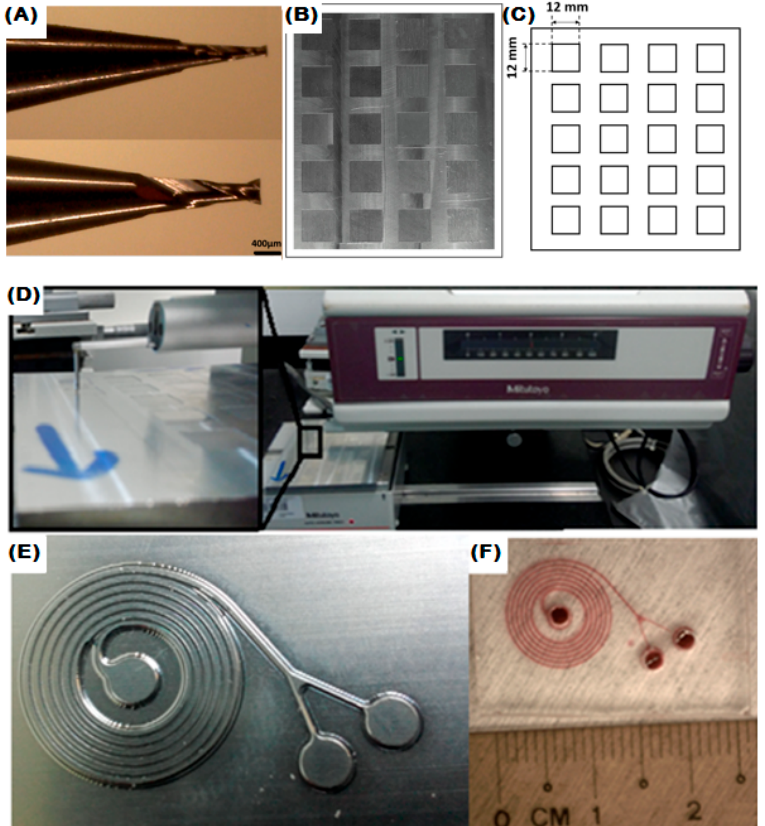
Figure 1. ( A ) Micro Endmill tool; ( B ) Micro-milled chamber with different cutting parameters; ( C ) Schematic of the micromilling chamber; ( D ) Surface Roughness Tester with Zoom out view; ( E ) Spiral master mold with optimum cutting combination; ( F ) Polydimethylsiloxane (PDMS) device fabricated from the master mold.